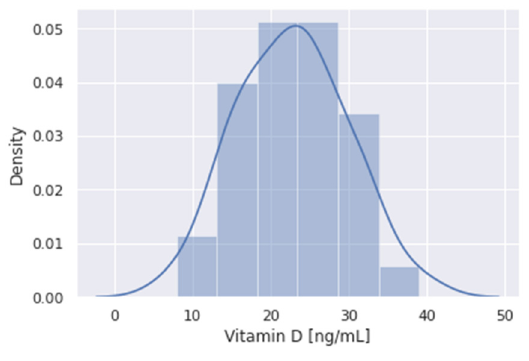
Figure 4. Frequency distribution of vitamin D levels of all evaluated study cohorts.